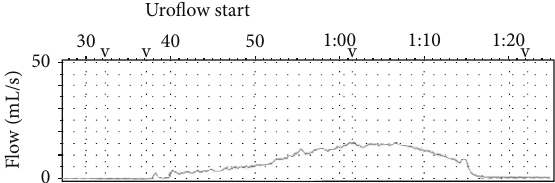
Figure 3: Uroflow after the operation revealed an increased flow with a maximal flow rate of 15mL/s, voided volume of 351 mL, and voiding time of 45